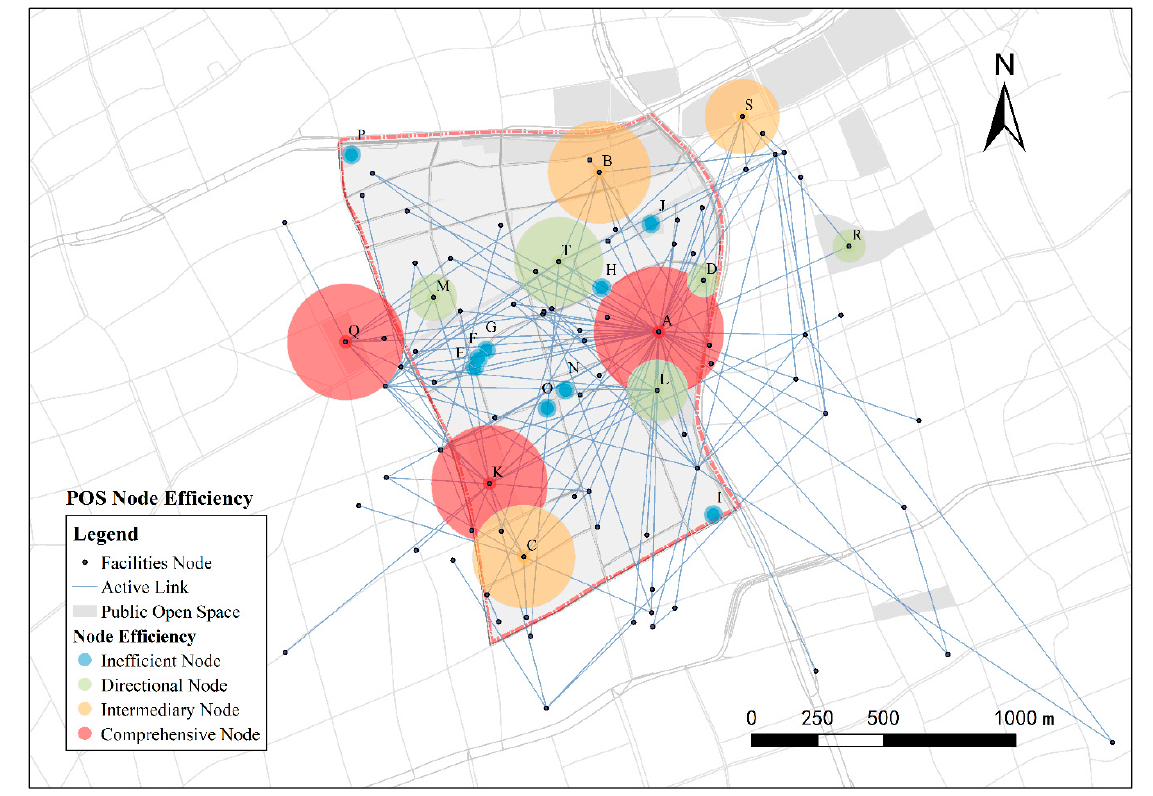
Figure 9. Node efficiency of the POS in the behaviour network. Table 6. Analysis of the effectiveness and renewal priority of POSs in the Ruijin community.